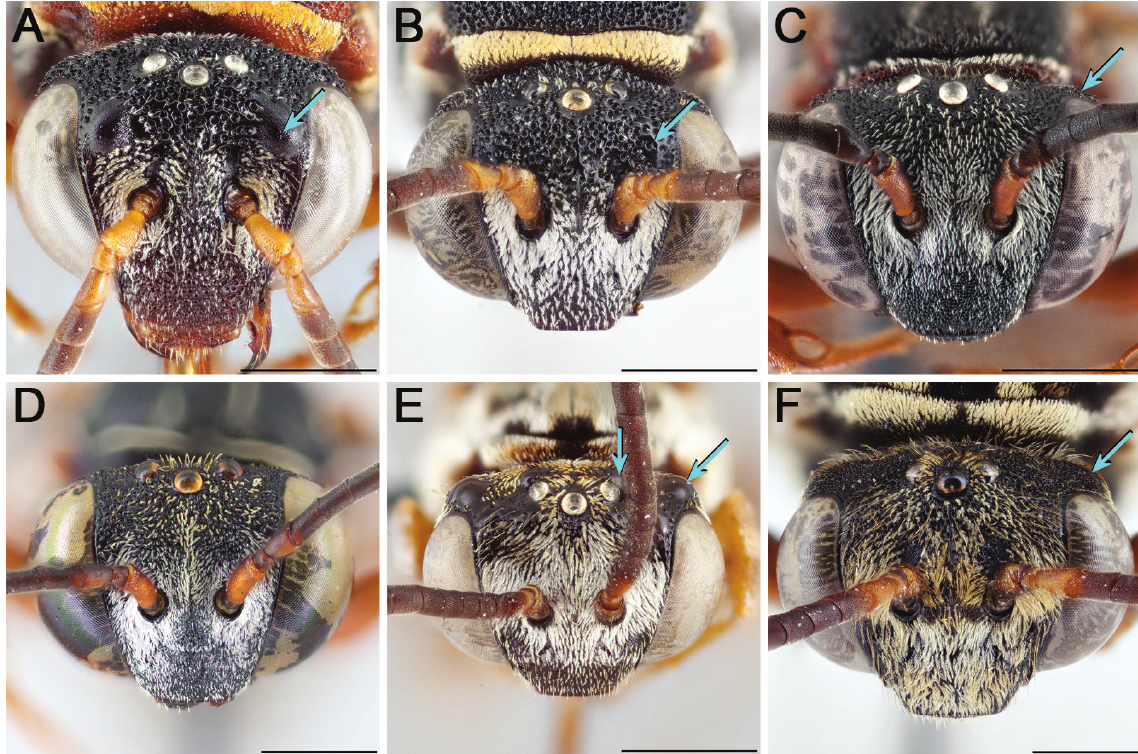
Fig. 4. Head of female. A . E. bifasciatus Cresson, 1864 showing frontal area with impunctate, granulose protrusion (blue arrow) on each side. B . E. obscuripes Cockerell, 1917 stat. nov. showing frontal area with very weak / inconspicuous protrusion (blue arrow) on each side. C . E. scutellaris Say, 1824 showing dorsal protrusion (blue arrow) on each side where upper genal area meets vertexal area. D . E. pusillus Cresson, 1864 showing frontal and vertexal areas without protrusions. E . E. chamaesarachae Onuferko, 2018, paratype, showing vertexal area with two shiny, impunctate protrusions (blue arrows) on each side. F . E. flavofasciatus Smith, 1879 showing single (closely punctate) dorsal protrusion (blue arrow) on each side where upper genal area meets vertexal area. Scale bars = 1